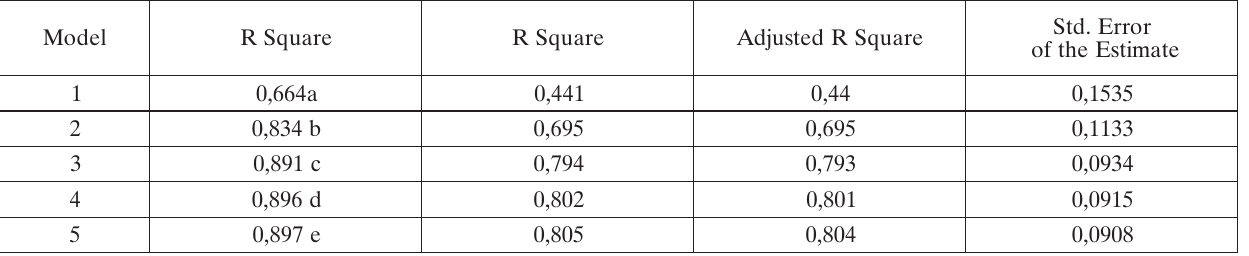
Table 7. Model Summary on pharmaceutical consumer